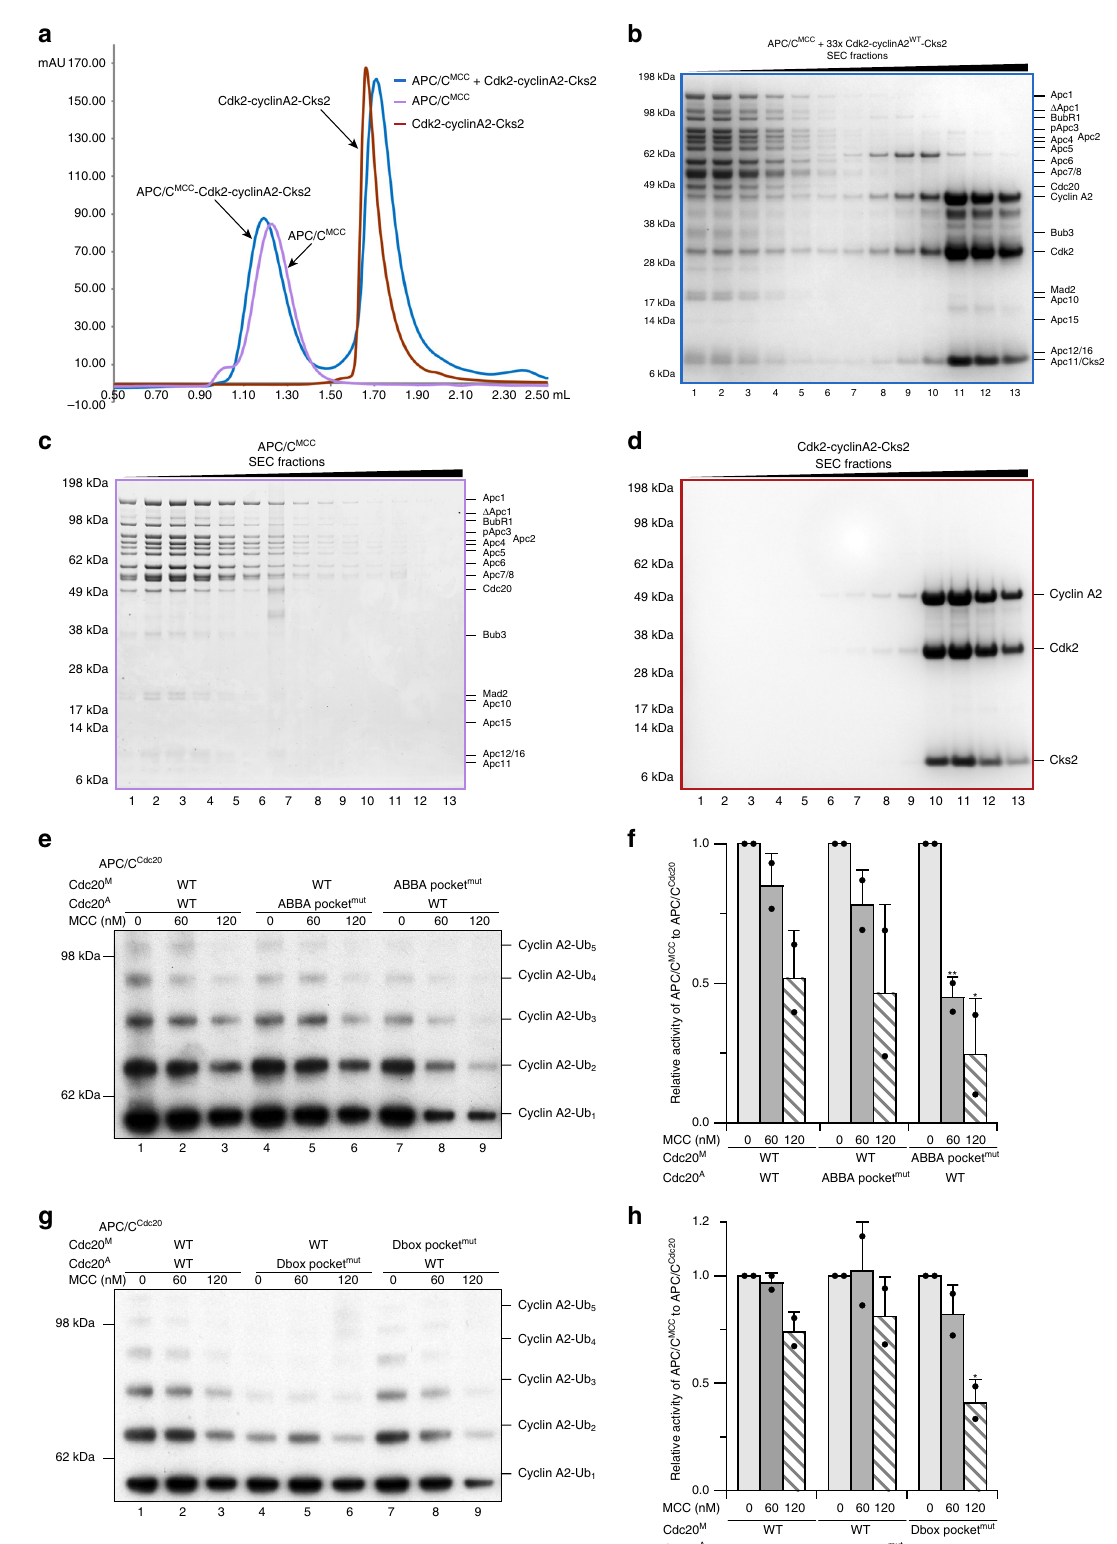
We showed that cyclin A2 interacts the D-box binding site of Cdc20 M within APC/C MCC . The D-box binding pocket on Cdc20 M is exposed at the periphery, whereas that on Cdc20 A is deeply buried between Cdc20 A and the APC/C 22,23 (Fig. 7a, b). Association of the D2 box of cyclin A2 with Cdc20 M would allow